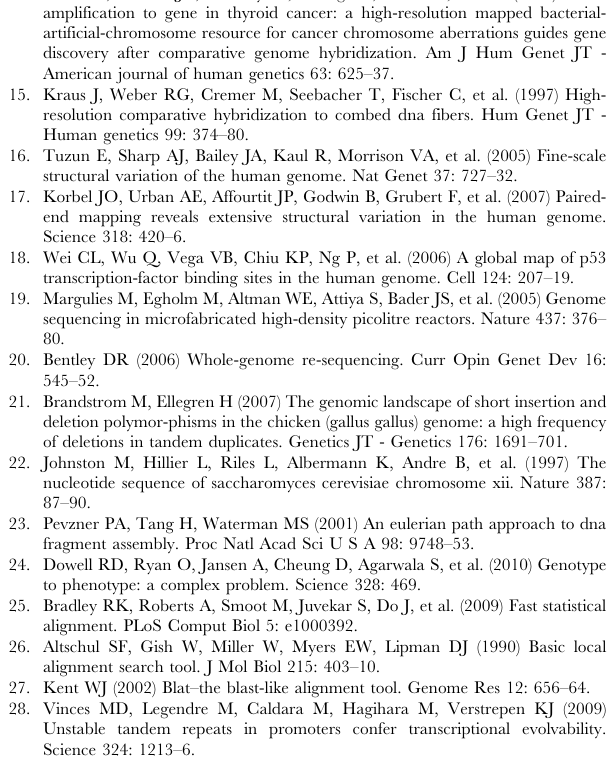
break but of lower magnitude to the left. If the change is large enough, the analysis calls this boundary an indel. This change is commonly observed at AT repeat length changes. Example (c) illustrates another change common at repeat length or repetitive element changes. There is a segment boundary in both channels, but the intensities drop much more in one channel than the other. A restriction site, or the insertion of an element that contains a restriction site such as a TY, generates the signature seen in (d). (PNG) Table S1 The 36 PCR-confirmed indels between S288C and S 1278b used for Ruler Array validation. (TXT) Text S1 Supporting text one presents the the normali- zation methods and linefitting technique.